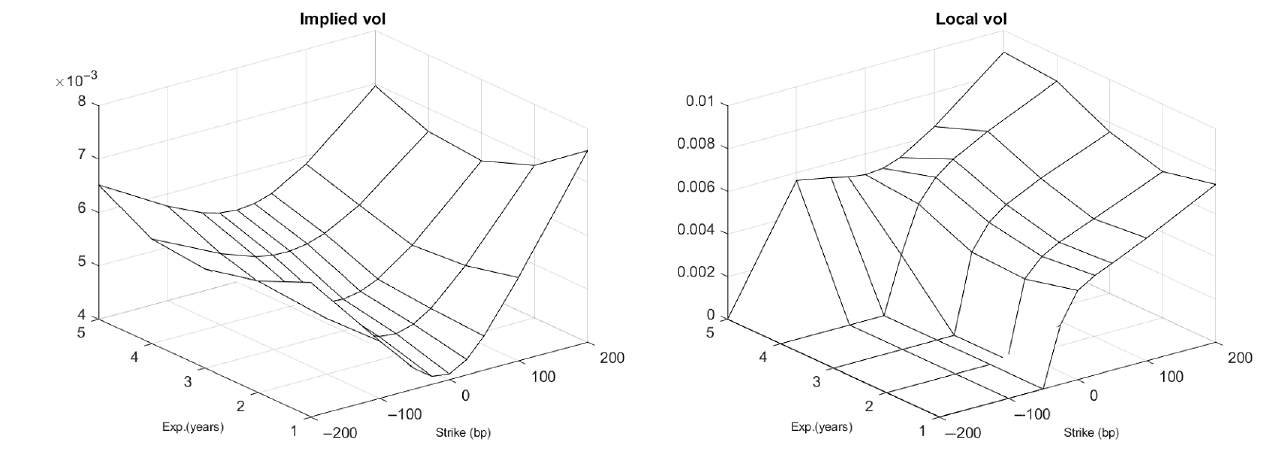
Figure 7. Implied volatility surface and its corresponding local volatility surface stripped using (101). Note: Terminal swap maturity is fixed at 6 years; US market data as of 28 September 2020; to avoid “sinkholes” local volatility floored at zero.